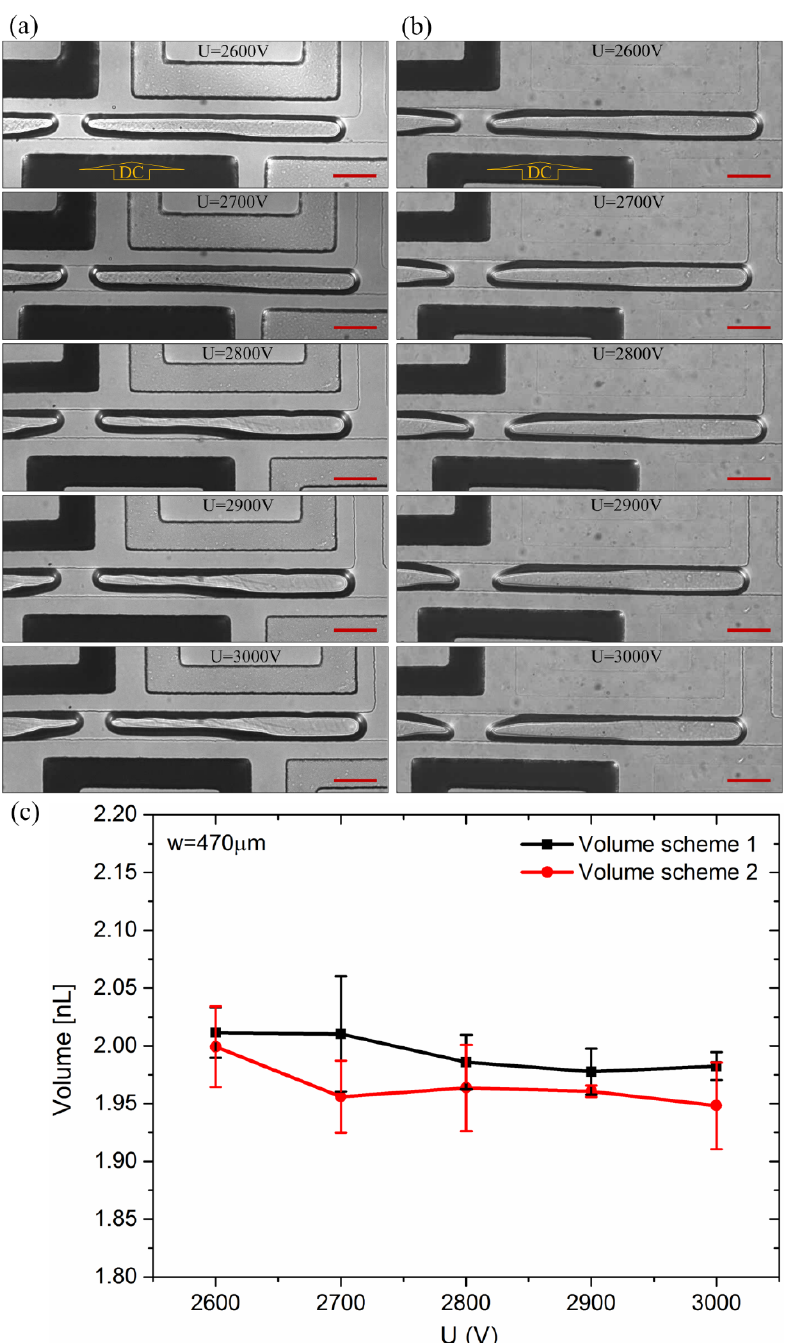
Figure 3. Droplets formed in di ff erent voltage in schemes. ( a ) The droplets formed in scheme 1; ( b ) the droplets formed in scheme 2; ( c ) the volume of the droplet in schemes 1 and 2 under the voltage from 2600 to 3000 V. The relative error was less than 3%. Voltage was applied on the electrode marked as “DC”. The scale bars are 100 µ